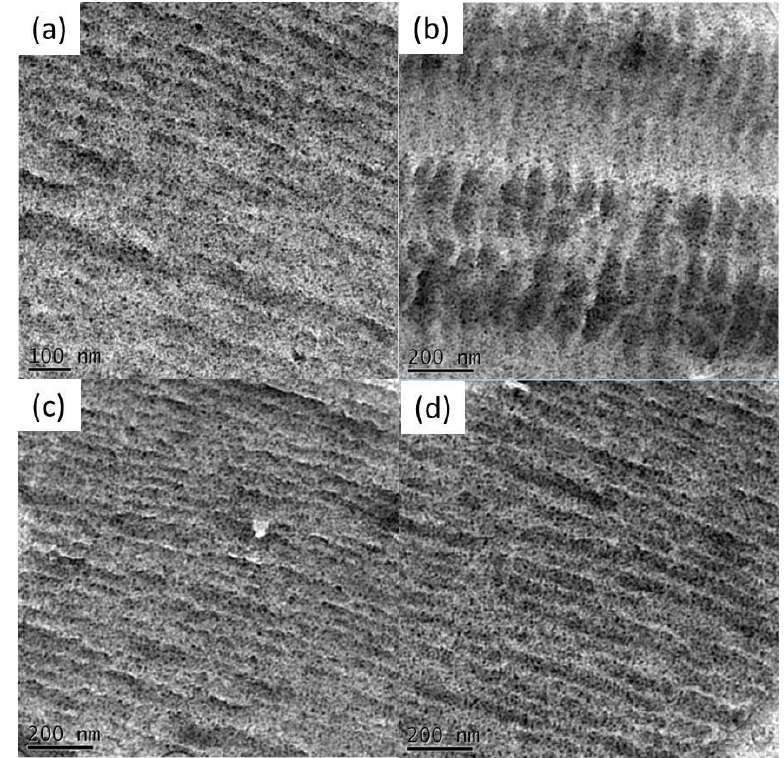
Figure 7. TEM images ( a – d ) of the hybrid block copolymer PVPh- b -PS-DDSQ-PS- b -PVPh.